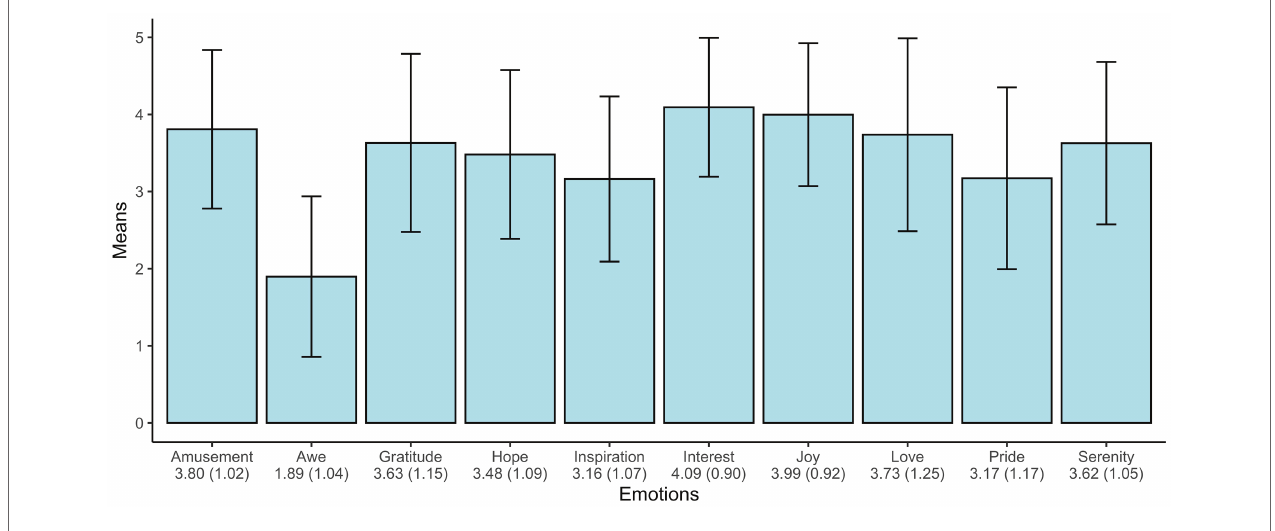
FIGURE 1 | Means and SDs (in parentheses) of the “Positive Ten”.